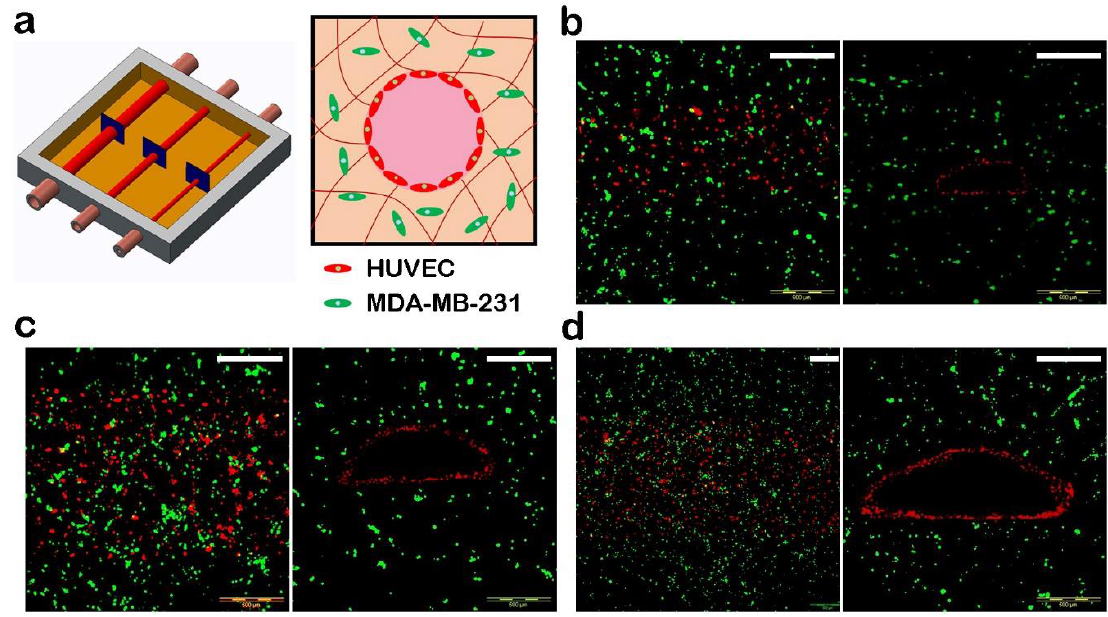
Figure 7. Three-dimensional vascularized tissues. ( a ) Schematic depicting a HUVEC-lined vascular channel. ( b – d ) Confocal microscopy images of the vascular network after 7 days; HUVEC (red), MDA-MB-231 (green). Chanel hydraulic diameters: (b) 1.4 mm, (c) 0.9 mm, and (d) 0.5 mm. (Scale bars: 500 μm).